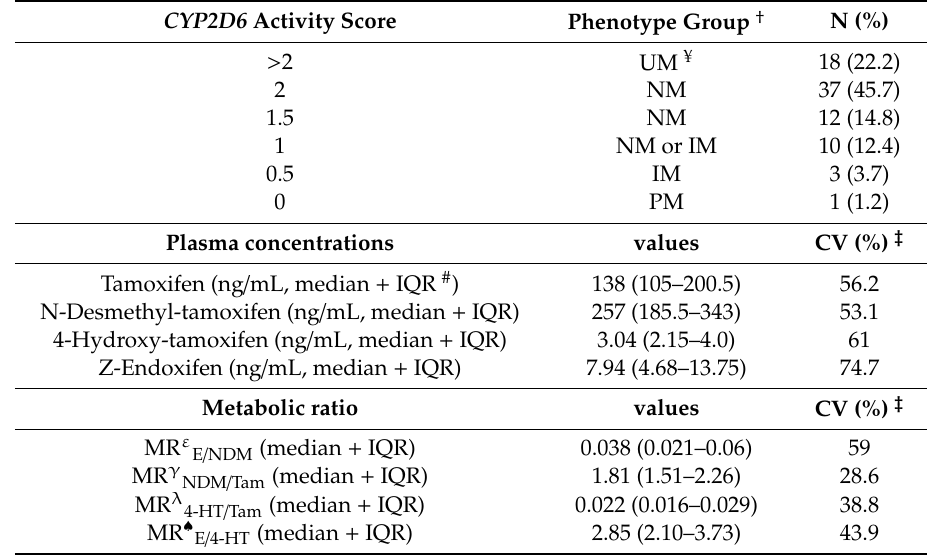
Table 3. CYP2D6 activity score and plasma concentrations of tamoxifen and its metabolite and respective metabolic